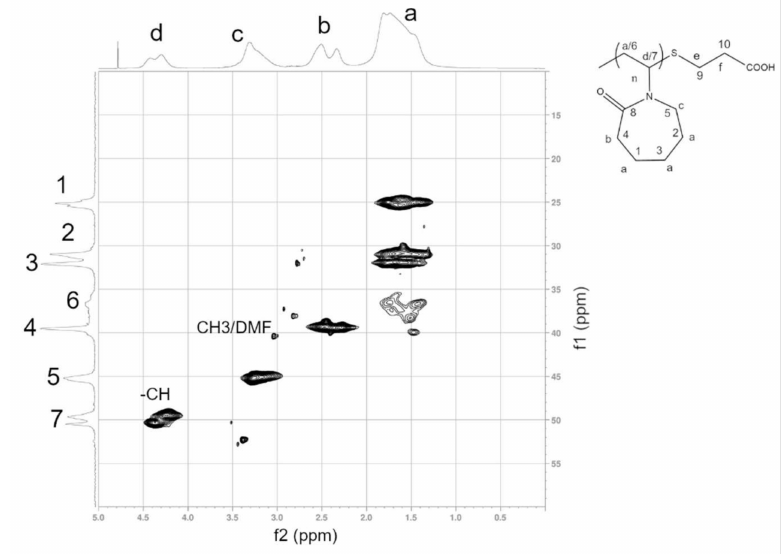
Figure 2. HSQC spectra of